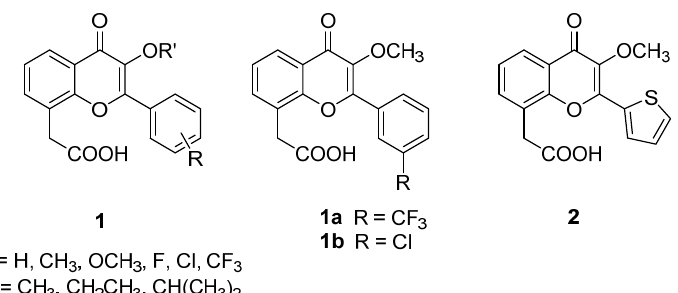
Figure 2. 3-Alkoxy FAA